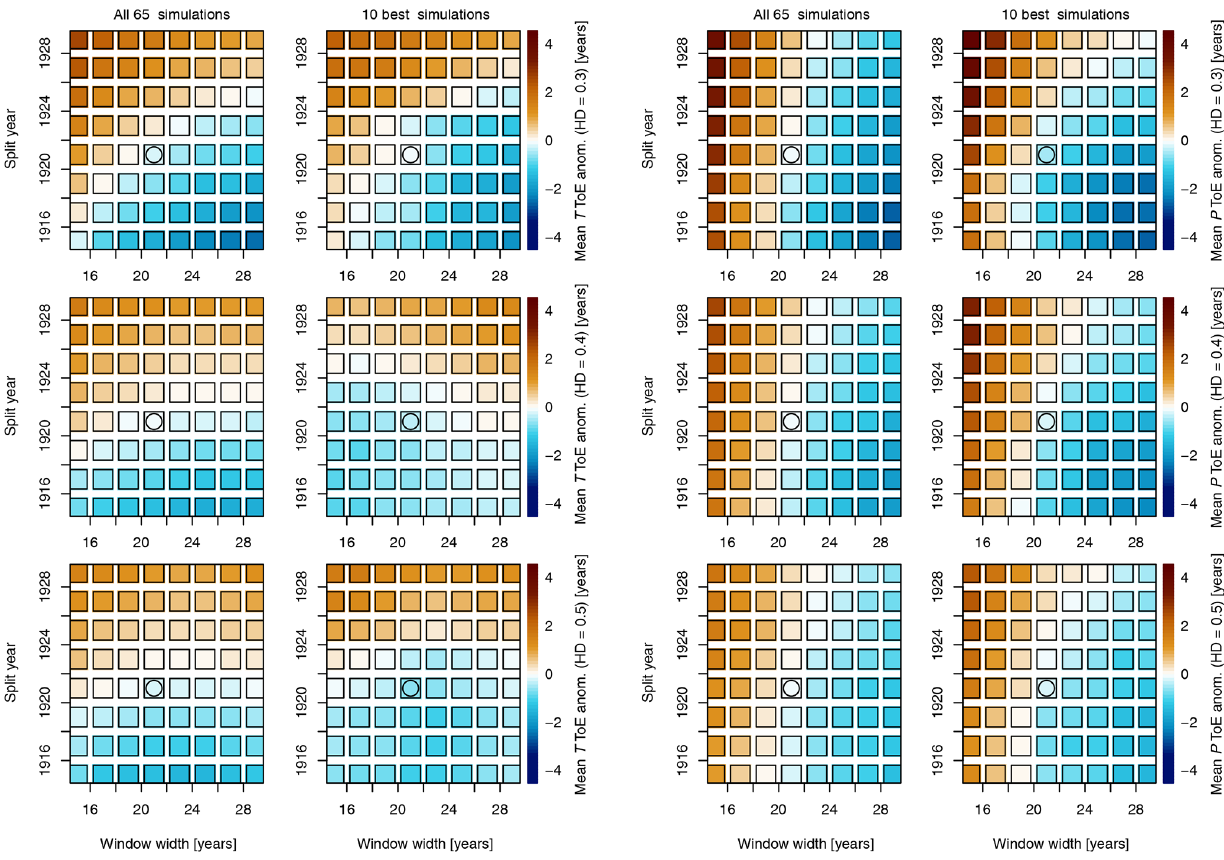
Figure 12. Impact of window width and split year on the ToE for T (left two columns) and P (right two columns) as the mean deviation from the mean over all combinations of window width and split year. Individual left columns for all 65 CSs and individual right columns for the subset of 10 best CSs. Rows show different emergence levels (30%–50%). The average ToE values and standard deviations are available in Figs. S8 and